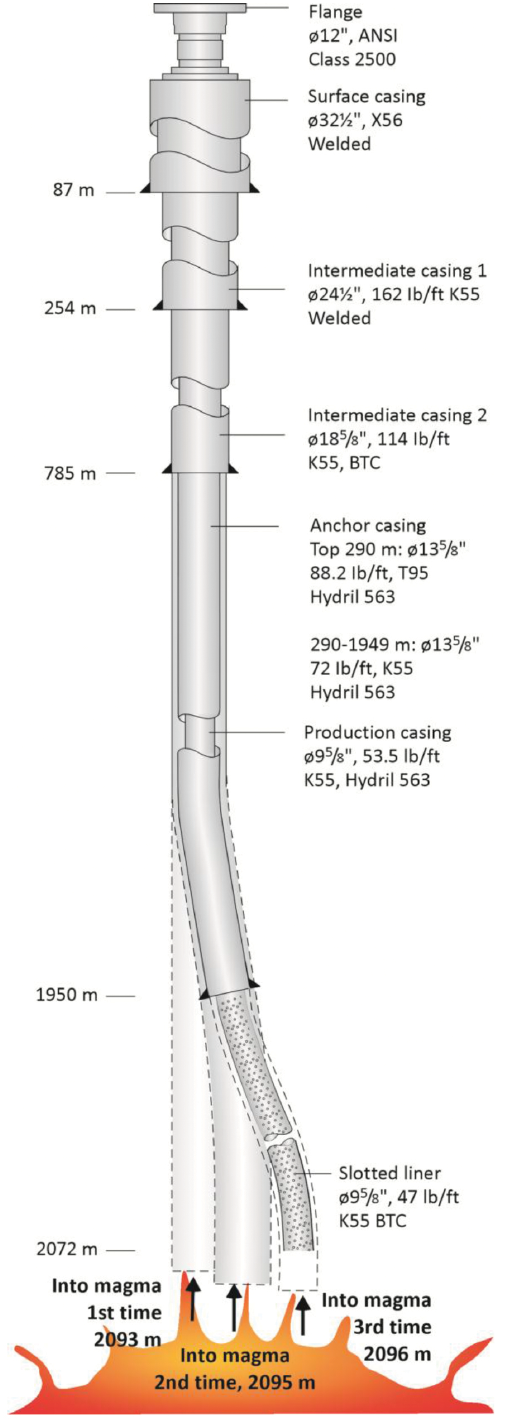
Figure 3. Well IDDP-1 at Krafla as